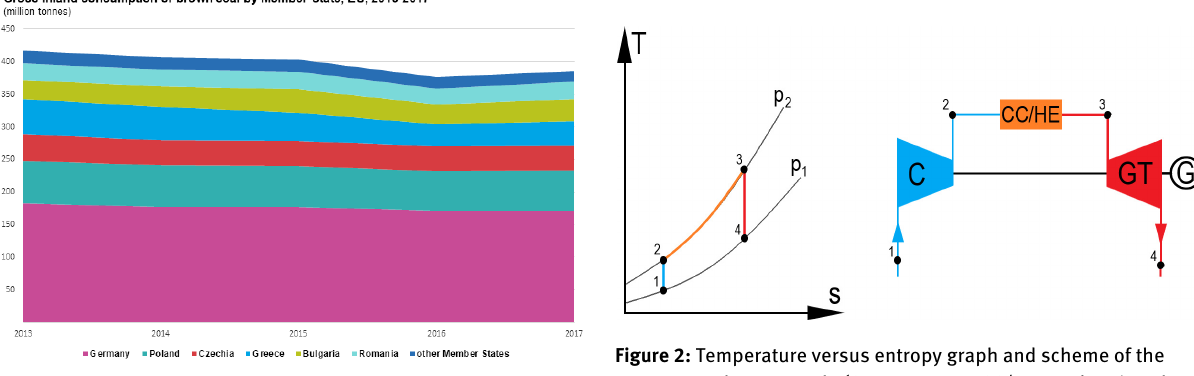
Figure 2: Temperature versus entropy graph and scheme of the Brayton–Joule open cycle (C-compressor, CC/HE-combustion cham- ber/heat exchanger, GT-gas turbine) The efficiency of the Brayton–Joule cycle depends di- rectly on the ratio of the difference between the work of a turbine l t = ( i 3 − i 4 ) and the work of a compressor l c = ( i 2 − i 1 ) to the heat supplied to the cycle q = i 3 − i 2 (where i is enthalpy). It is also indirectly connected with a tem- perature difference at the inlet and outlet of the